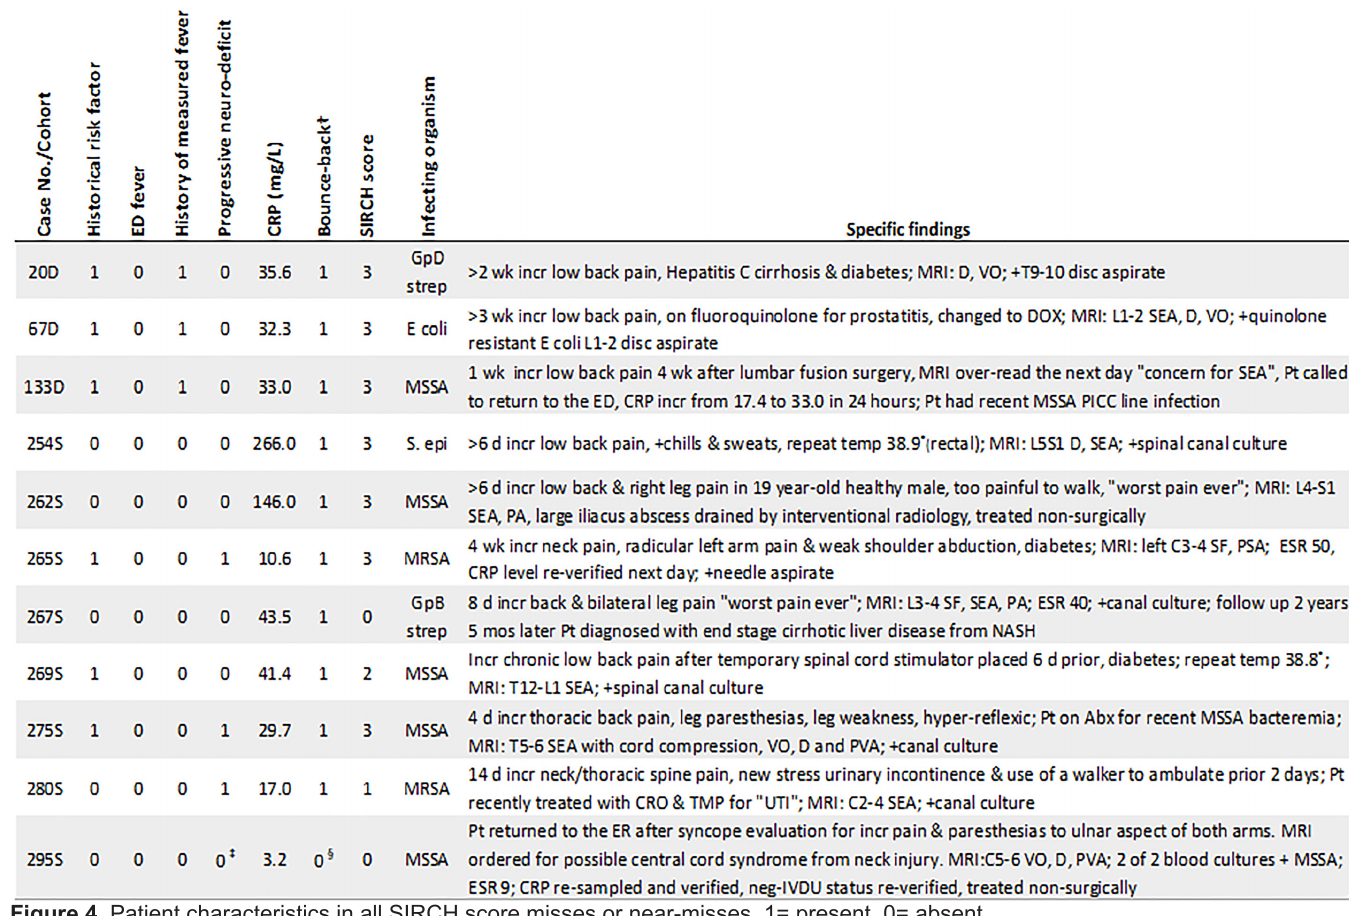
Figure 4. Patient characteristics in all SIRCH score misses or near-misses. 1= present, 0= absent. †Bounce-back= a prior ED/clinic visit related to current visit; ‡MRI ordered based on suspicion of central cord syndrome but adjudicated not a progressive neurological deficit. §Not considered a bounce-back since patient’s first visit unrelated to PSI; PSI, pyogenic spinal infection; SEA, spinal epidural abscess; VO, vertebral osteomyelistis; D, discitis, PVA, paravertebral abscess; PSA, paraspinous abscess; SF, septic facet; PA, psoas abscess; Abx, antibiotics; CRO, ceftriaxone; DOX, doxycycline; TMP, trimethoprim- sulfamethoxazole; SSTI, skin and soft tissue infection; MSSA, methicillin sensitive Staphylococcus aureus ; MRSA, methicillin resistant Staphylococcus aureus ; S epi, Staphylococcus epidermidis ; d, day; wk, week; incr, increasing; ESR, erythrocyte sedimentation rate; NASH, non alcoholic steatohepatitis; Pt,